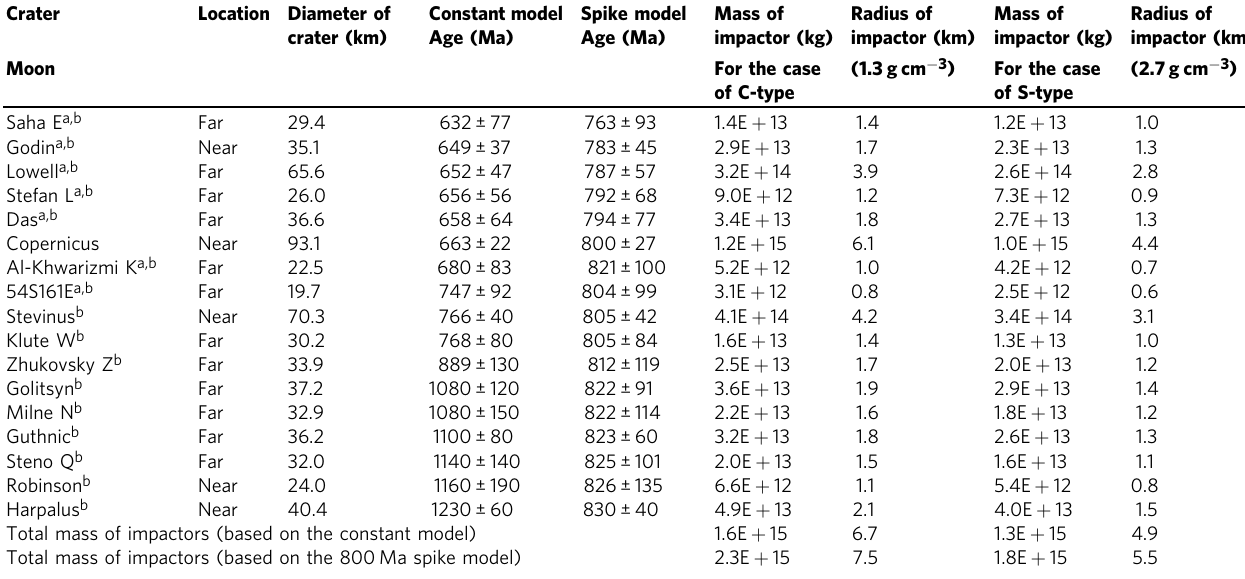
Table 2 The estimated mass and size of impactors which formed the craters with the Copernicus formation simultaneously.